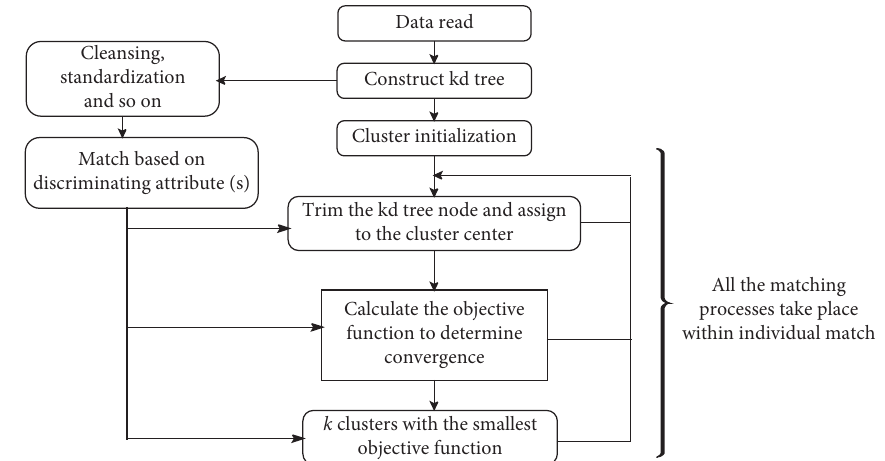
Figure 3: Processing flow of cluster analysis